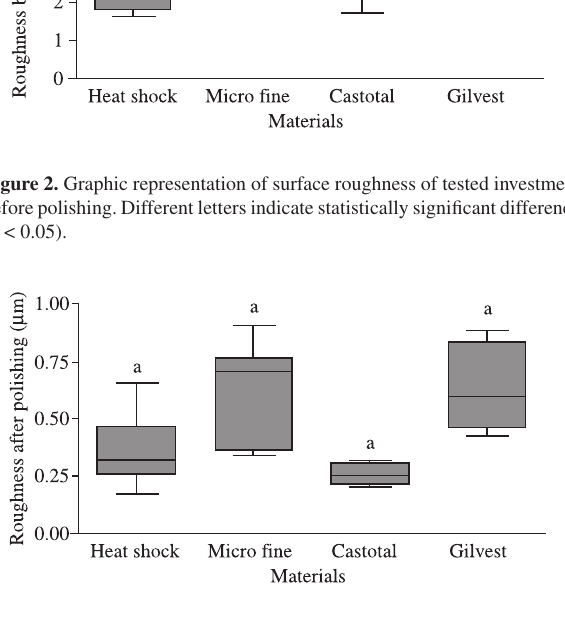
Figure 3. Graphic representation of surface roughness of tested investments after polishing. Same letters indicate no statistically significant differences (p >